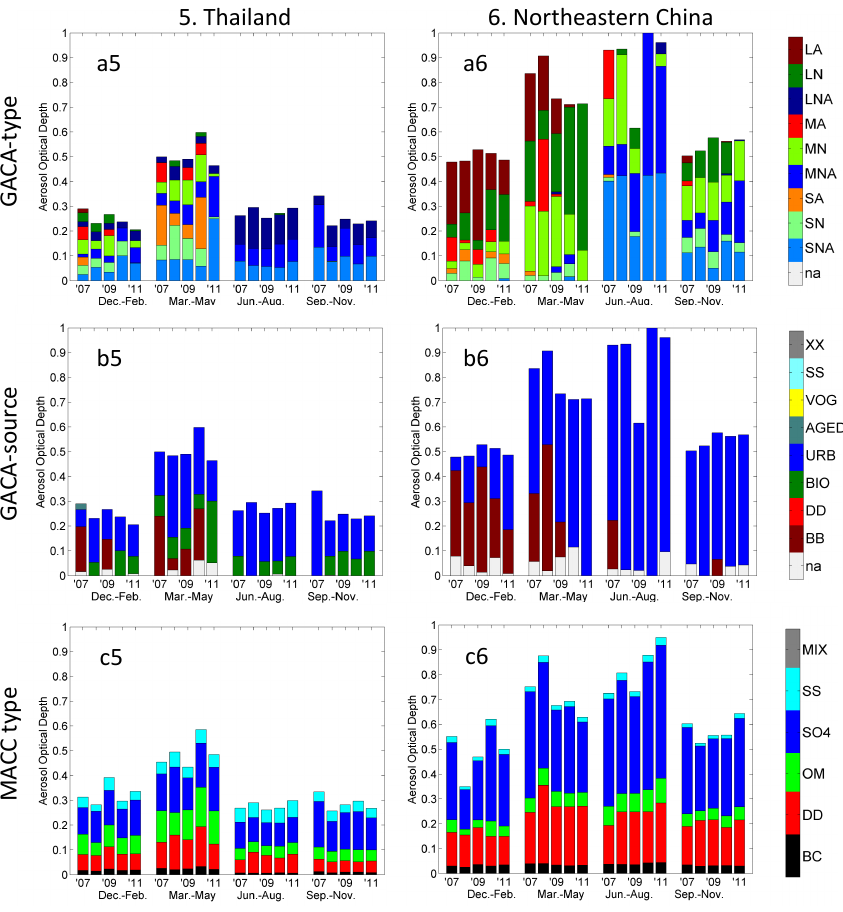
Figure 12. Seasonal cycles of global aerosol type and source according to GACA and MACC for 5 ◦ × 5 ◦ regions in Thailand (15–20 ◦ N, 100–105 ◦ E) and northeastern China (35–40 ◦ N, 115–120 ◦ E). See Fig. 10 for